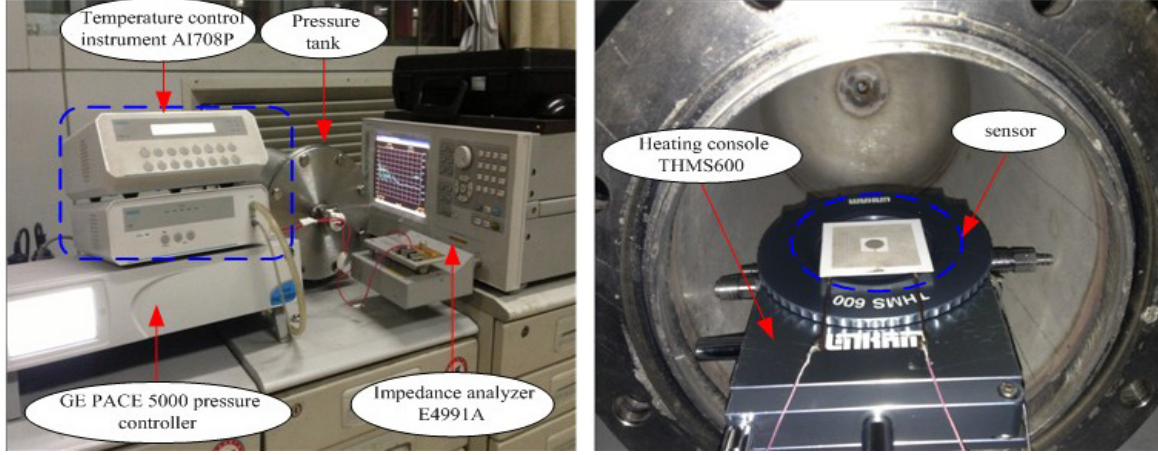
Figure 11. High-temperature-pressure test system image. ( Left ) Entire test setup; ( Right ) Inside the